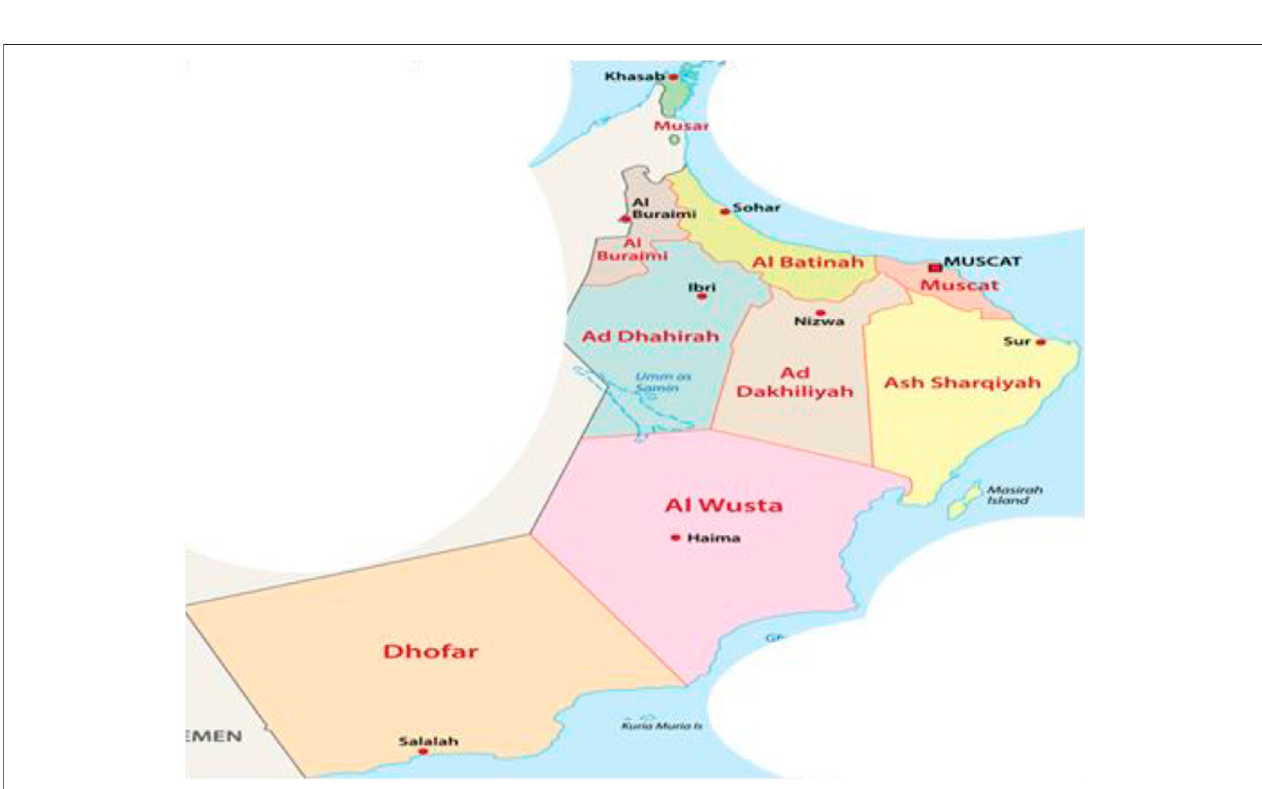
FIGURE 2 | Waste distribution in Oman (Mohammed, 2015; Ithraa,